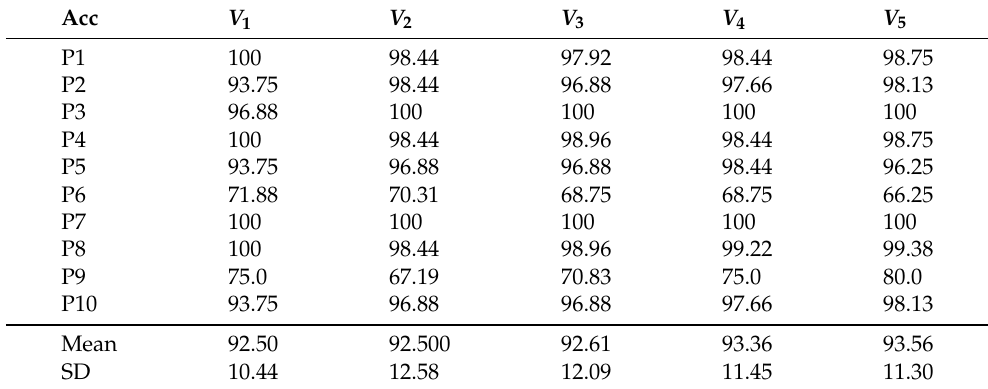
Table 3. Accuracies of the different variants for the tested 10 participants